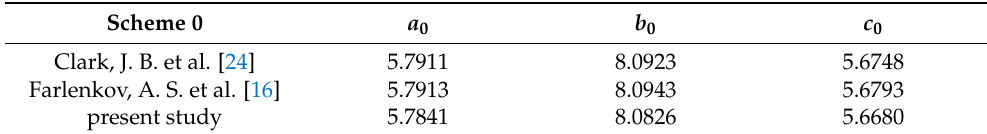
Table 3. Experimentally measured and calculated LaScO 3 lattice constants in Å. Atomic coordinates are given in Table